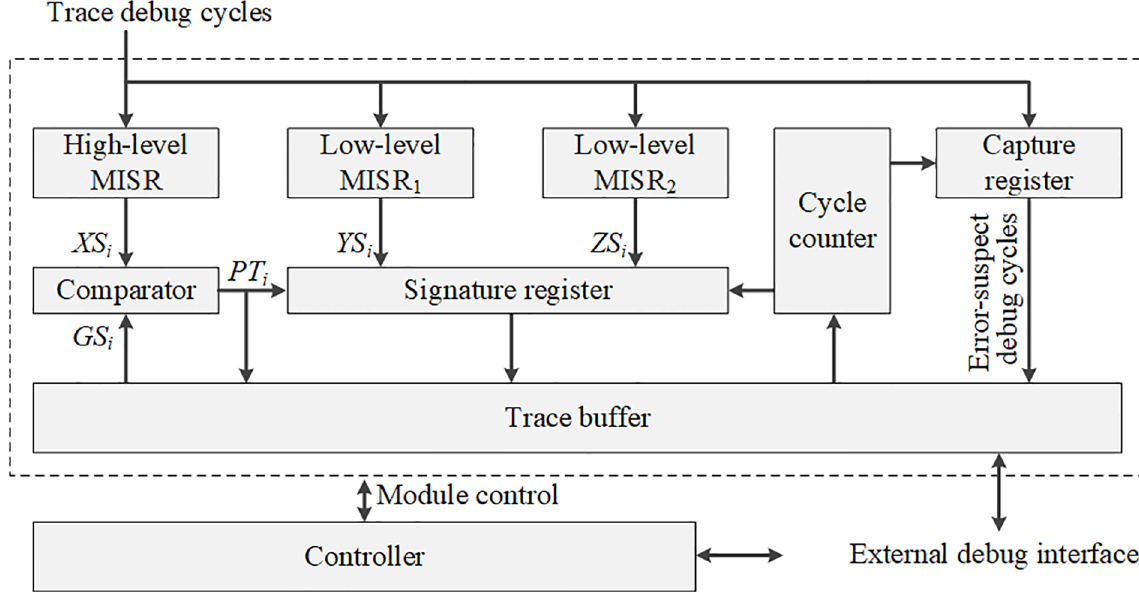
Fig 7. Hardware structure of the proposed debug